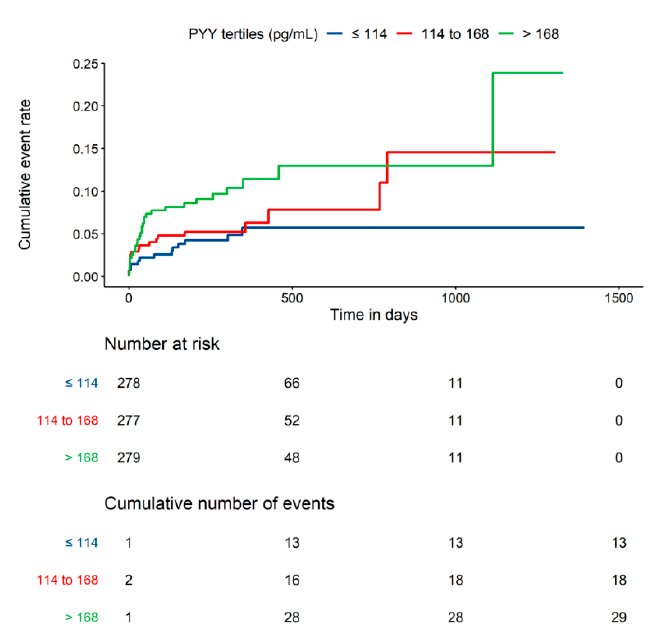
Figure 1. Kaplan–Meier cumulative event curves for all-cause mortality with patients separated by PYY tertiles. Table 3. Multivariable Cox regression for log